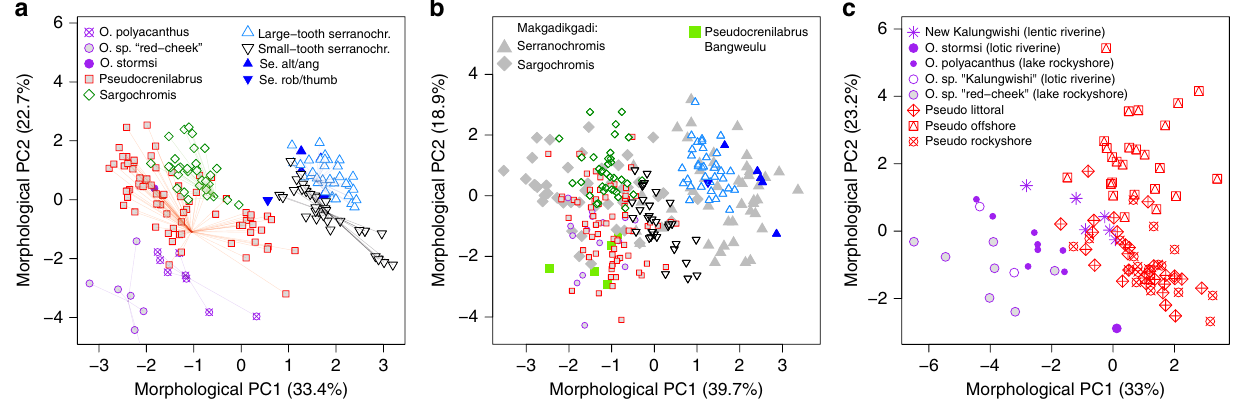
Fig. 2 Morphological variation and morphospace partitioning between Lake Mweru radiations. a Morphological complementarity of the four intralacustrine cichlid radiations, the lacustrine members of the Orthochromis assemblage, the non-endemic Serranochromis altus and Se. angusticeps (Se. alt/ang), the nonendemic Se. robustus and Se. thumbergi (Se. rob/thumb) and Orthochromis stormsi ( O. stormsi ) in Lake Mweru. The fi rst two principal components of all haplochromine cichlid species we found in Lake Mweru show nearly perfect complementarity in morphospace occupation among the radiations. Of the Orthochromis species, only the taxa occurring in Lake Mweru, O. polyacanthus and O . sp. “ red-cheek ” are shown, but not the seven riverine species of the Kalungwishi and Luongo Rivers. Sister taxa of each radiation are indicated with fi lled symbols. Their centroids or that of the radiations themselves (in the absence of sister taxa) are connected by thin lines to each phenotype of the corresponding radiation to visualize approximate trajectories of phenotypic divergence and diversi fi cation. The underlying data and the R script for all panels are provided at Zenodo with doi: 10.5281/zenodo.3435419. b Mweru taxa predicted onto morphospace of serranochromines of the radiation of ancient Lake Makgadikgadi. Makgadikgadi Sargochromis include Chetia and Pharyngochromis species which are nested in the genus Sargochromis 42 . In the presence of a diverse Pseudocrenilabrus radiation in Lake Mweru, the serranochromine radiations altogether are con fi ned to a subset of the morphospace this lineage occupies elsewhere (such as in the Okavango region, the modern centre of Makgadikgadi-derived diversity). This is mostly due to much reduced morphological diversity in Sargochromis of Lake Mweru. Compared to Pseudocrenilabrus of Lake Bangweulu, the Pseudocrenilabrus radiation in Lake Mweru expanded into serranochromine morphospace. c In the presence of the Pseudocrenilabrus radiation in the lake, Orthochromis are con fi ned to the epilithic algae and Aufwuchs scraper niche in the rocky wave washed littoral of the lake, an extreme feeding niche that the Pseudocrenilabrus radiation has not invaded. In the rivers, where Pseudocrenilabrus have not radiated and only the ancestral type P. philander is present, two species with partial Orthochromis and partial Pseudocrenilabrus ancestry evolved in lentic, i.e. lake-like, parts of the river. These “ New Kalungwishi ” species overlap in morphospace with littoral Pseudocrenilabrus from Lake